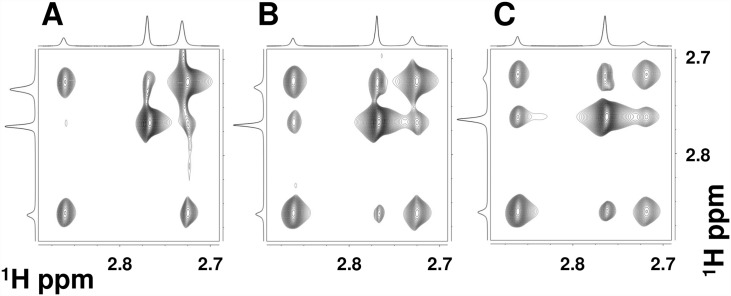
Effect of increasing bicarbonate concentration: Methyl region of the 400 MHz two-dimensional exchange spectroscopy (EXSY) spectra with increasing BMAA: HCO3-ratio: (A) 1:10, (B) 1:20 and (C) 1:30.The BMAA concentration was at 10 mM. EXSY spectrum is recorded at 30°C and with a mixing time of 400 ms.